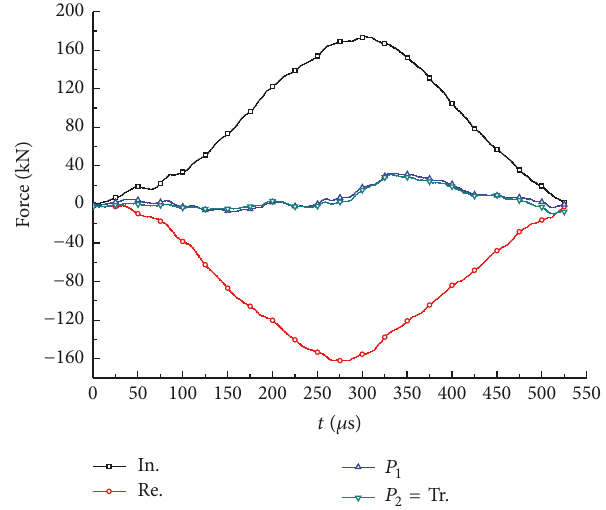
Figure 4: Dynamic force balance check.